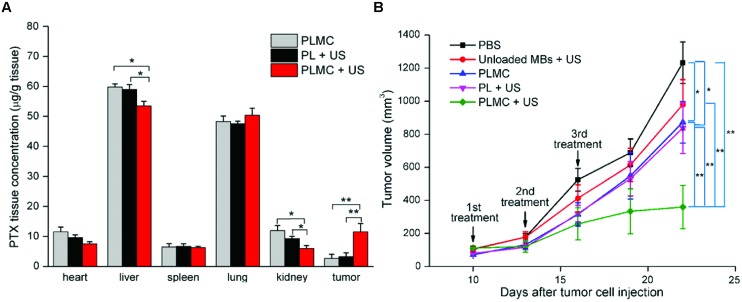
Paclitaxel (PTX) delivery by PTX-loaded microbubble with ultrasound for breast cancer treatment (Adapted with permission from Yan et al., 2013 – Copyright © 2013 Elsevier Ltd.). (A) Paclitaxel in vivo distribution in heart, liver, spleen, lung, kidney and tumors 1 h after injection of paclitaxel-loaded microbubble complexes (PLMC) alone, paclitaxel liposomes (PL) + US or PLMC + US; (B)
In vivo growth inhibition in 4T1-tumor bearing mice within 22 days. Mice were treated with PBS (squares), unloaded microbubbles + US (circles), PLMC without US (upward triangles), PL + US (downward triangles) or PLMC + US (diamonds) on days 10, 13 and 16 after tumor cell injection. Results represent mean ± SD, n = 6. ∗p < 0.05; ∗∗p < 0.01.